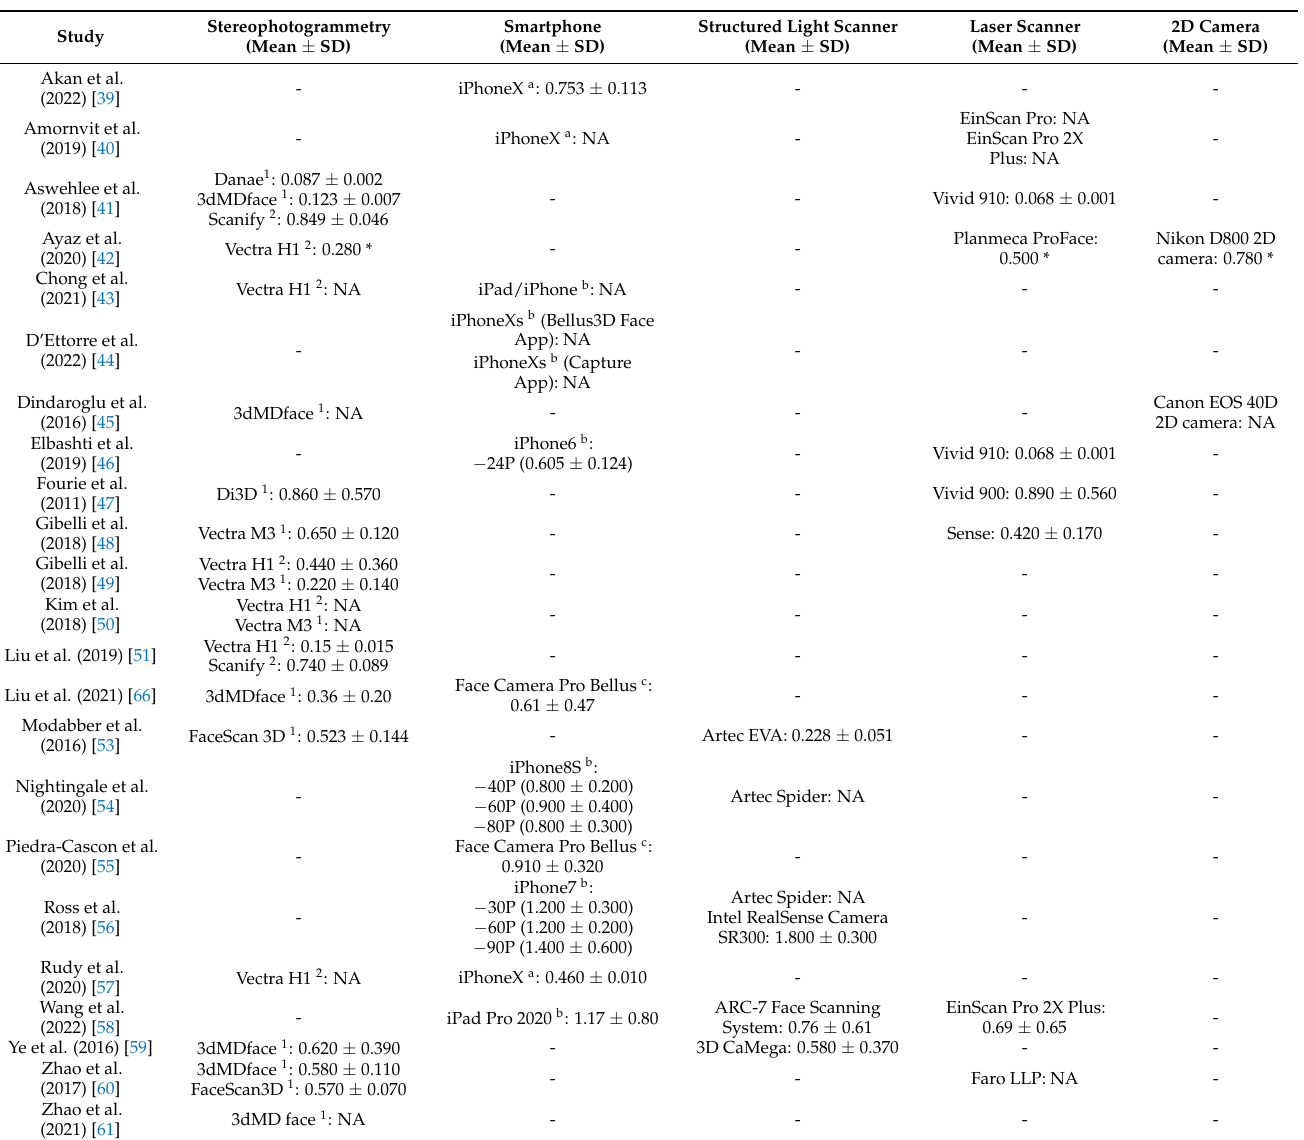
Table 4. Results of the scanners’ mean accuracy (expressed in millimeters) in the selected studies. NA: not available. * SD not reported; 1 Stationary stereophotogrammetry; 2 Portable stereopho- togrammetry; a smartphone 3D scanner; b 2D photogrammetry; c tablet connected to a portable dual-structured light scanner; P: